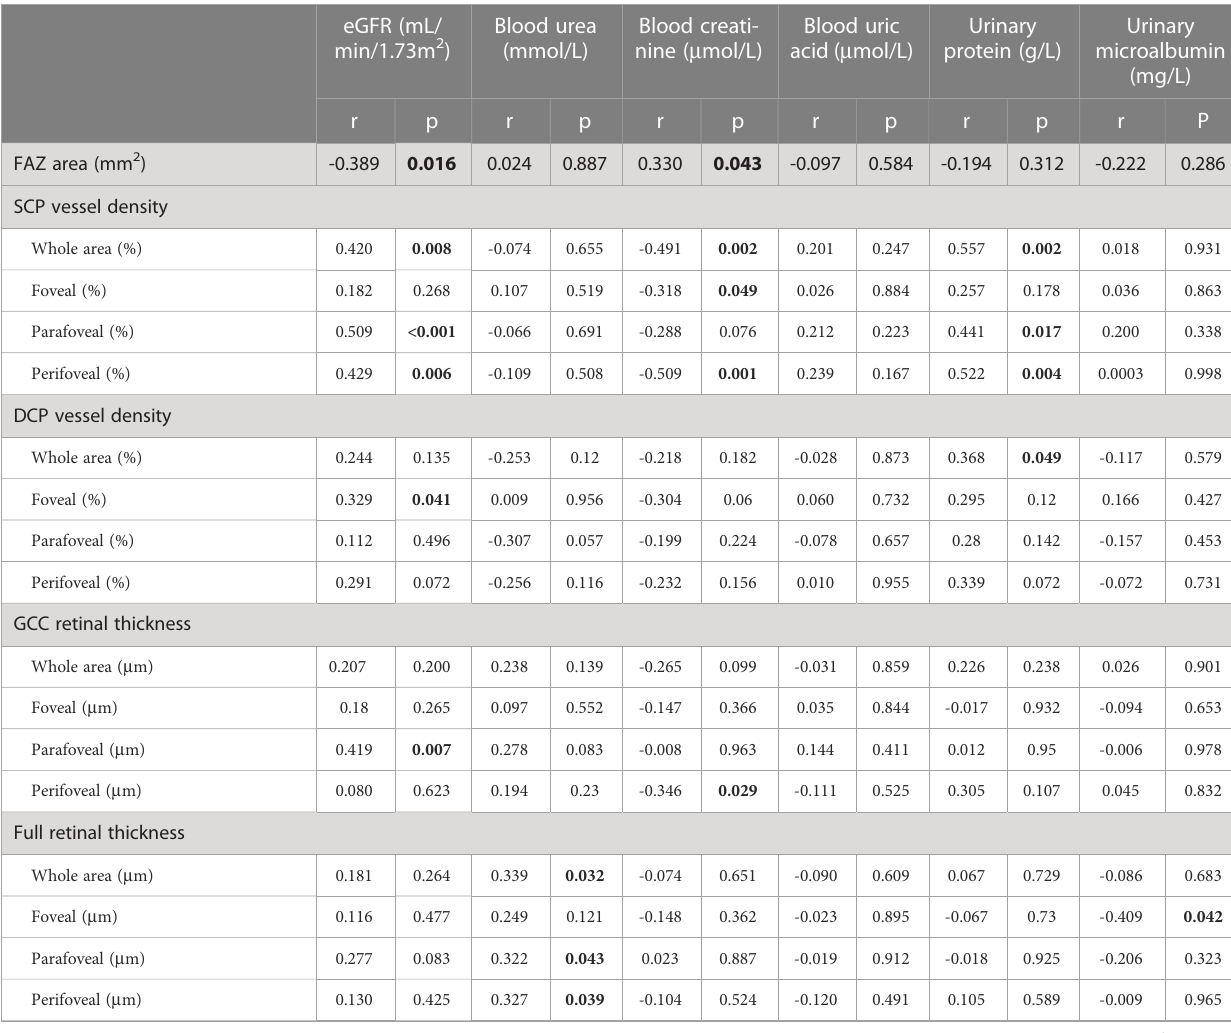
TABLE 6 Correlation analysis between renal function parameters and optical coherence tomography (angiography) parameters in non-diabetic nephropathy individuals.